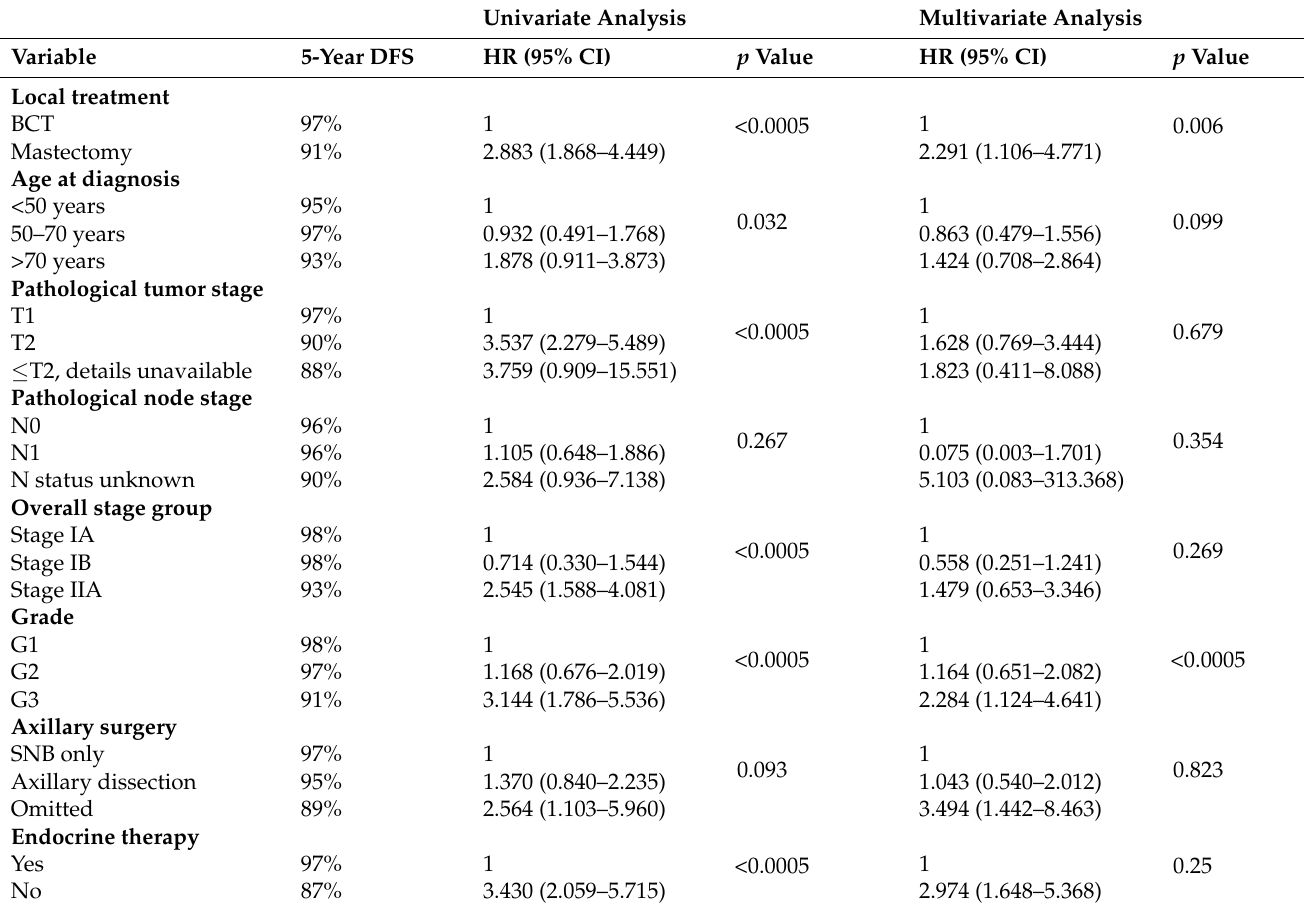
Table 4. Univariate and multivariate Cox regression analysis for 5-year disease-free